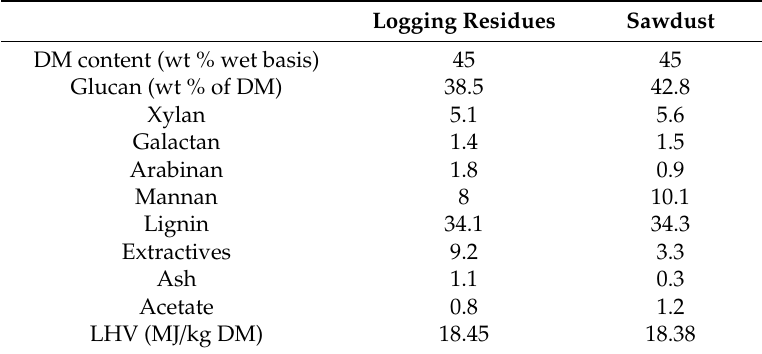
Table 1. Chemical composition of logging residue and sawdust